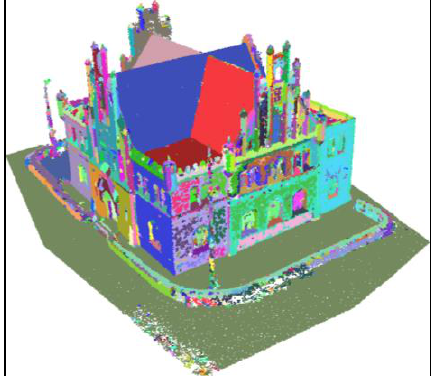
Figure 10.The extracted surfaces through point cloud processing procedure